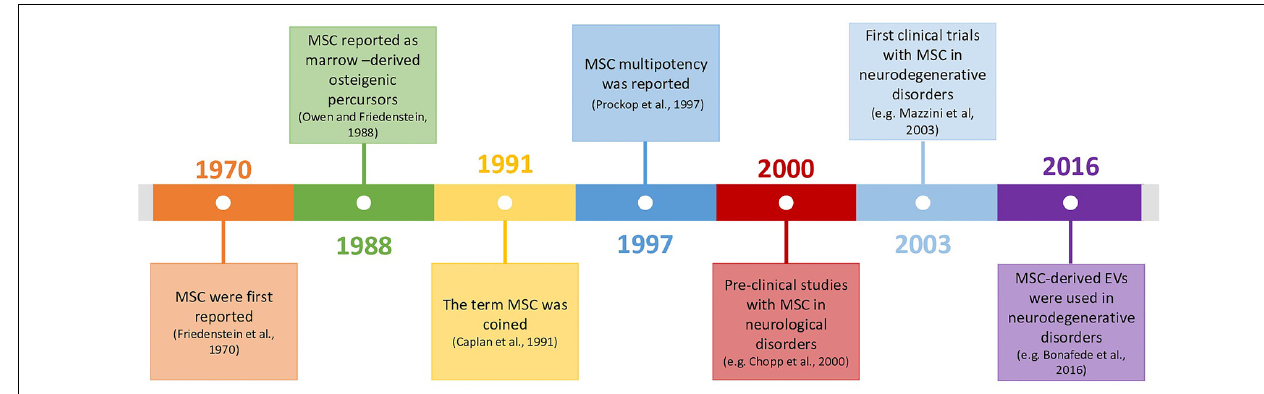
FIGURE 1 | Timeline of mesenchymal stromal cells (MSC)’s history and their use in neurodegenerative disorders (Friedenstein et al., 1970; Owen and Friedenstein, 1988; Caplan, 1991; Prockop, 1997; Chopp et al., 2000; Mazzini et al., 2003; Bonafede et al., 2016).